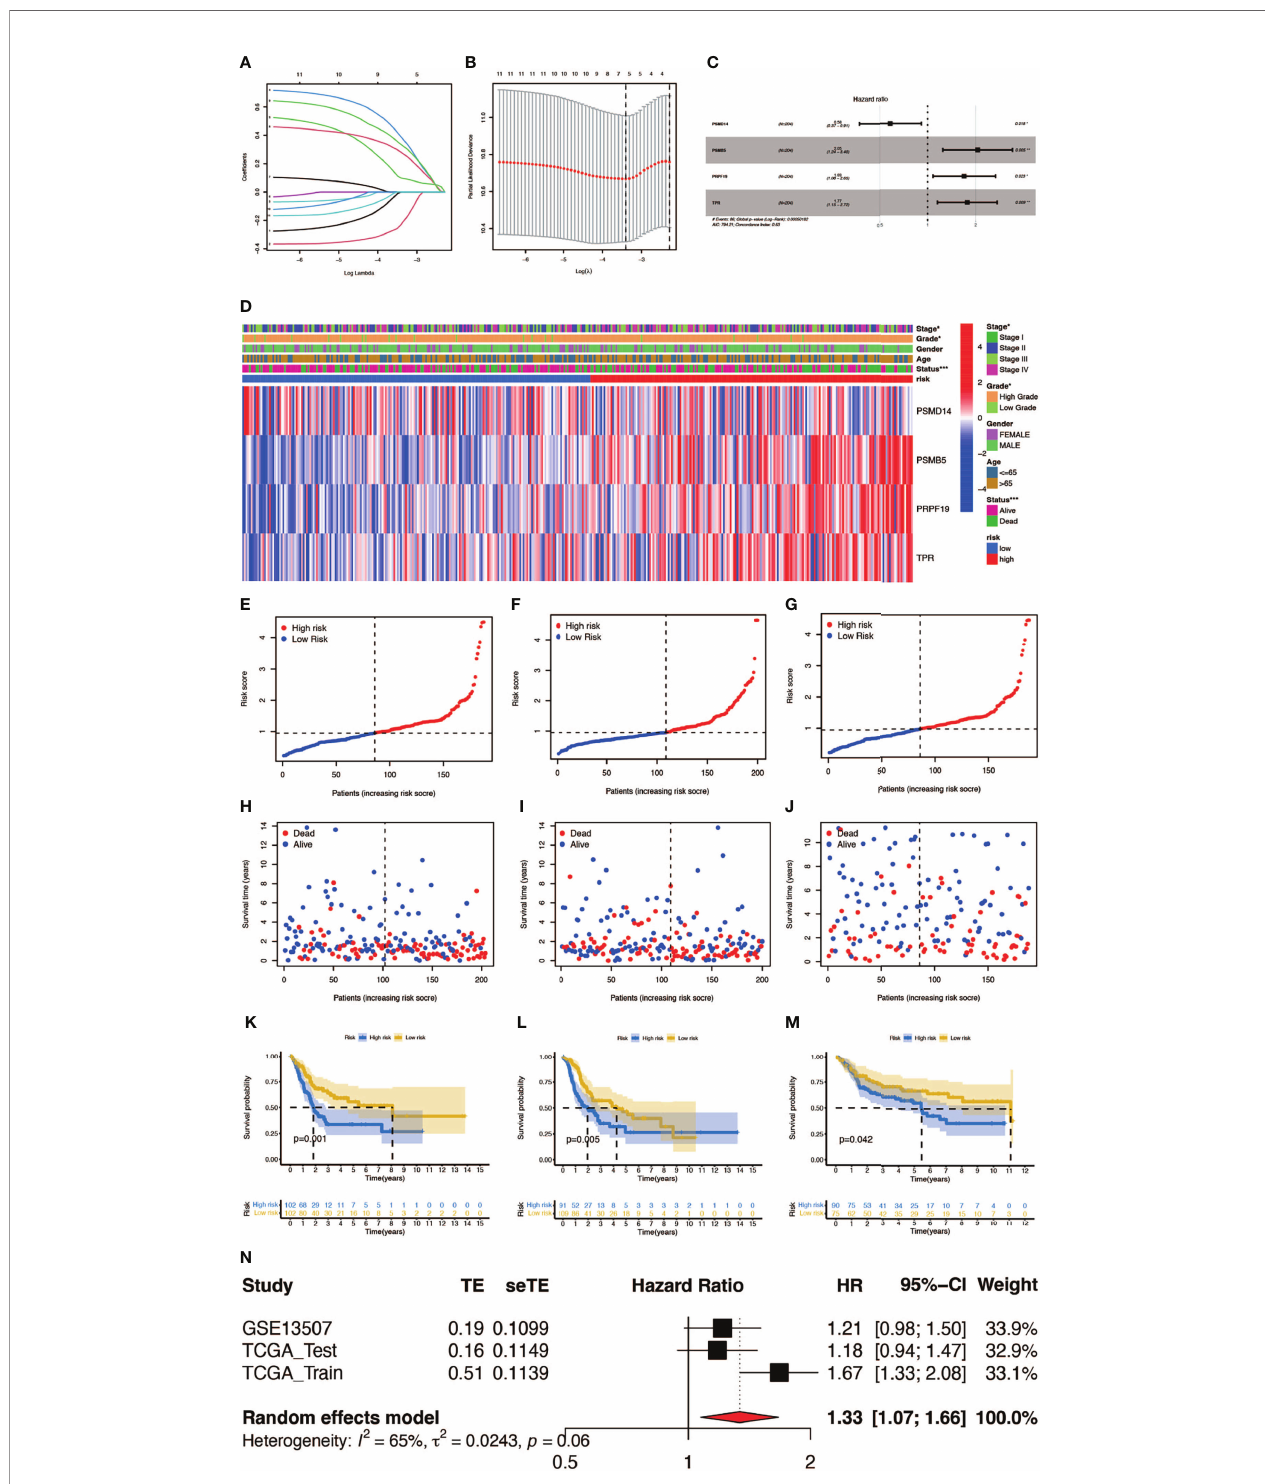
FIGURE 3 | Construction and veri fi cation of the prognostic index. (A, B) Result of LASSO regression analysis. (C) Hazard ratio of each gene after multivariate Cox regression analysis. (D) The distribution of clinical characteristics of patients in the high- and low-risk score groups. (E – G) Risk scores of each patient in the training cohort, testing cohort, and veri fi cation cohort. (H – J) Survival status of each patient in the training cohort, testing cohort, and veri fi cation cohort. (K – M) Kaplan – Meier survival analyses of each patient in the training cohort (P = 0.001, log-rank test), testing cohort (P = 0.005, log-rank test), and veri fi cation cohort (P = 0.042, log-rank test). (n) Meta-analysis of the training cohort, testing cohort, and veri fi cation cohort (*P < 0.05; **P < 0.01; ***P <